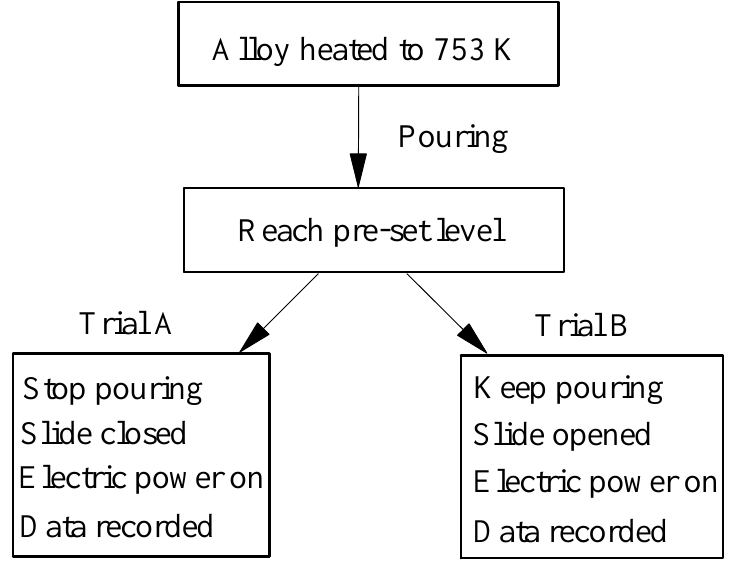
Figure 2. Experiment procedures for trials A and